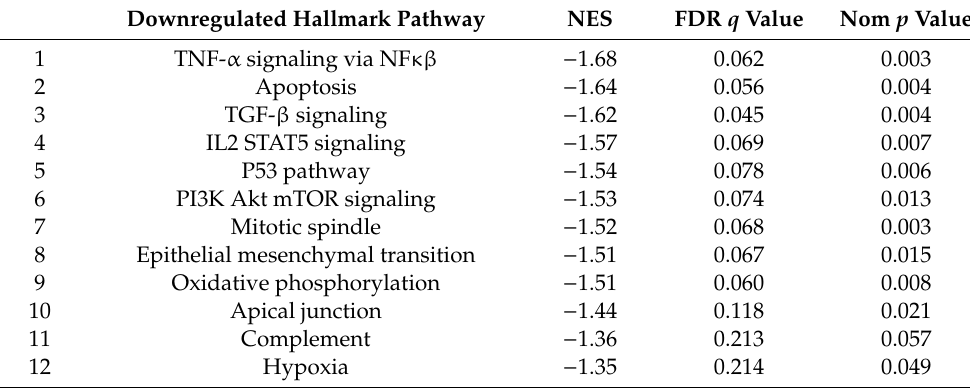
Table 1. Gene Set Enrichment Analysis (GSEA) results according to the MSigDB Hallmark gene sets. GSEA of downregulated genes in RKI-144 treated D425 cells (1 µ M for 24 h) compared to vehicle control. NES = normalized enrichment score. Enrichments were considered significant if false discovery rate (FDR) < 0.25. Nom =